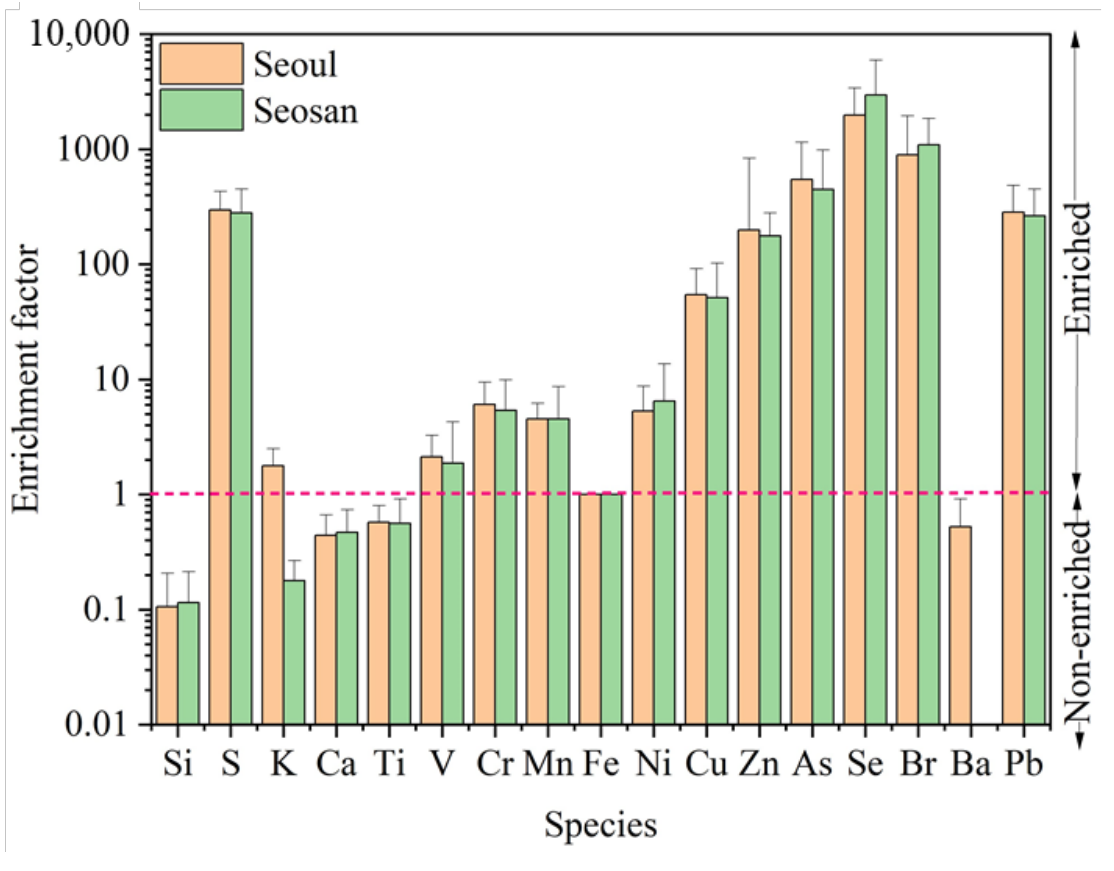
Figure 2. Enrichment factors of elements in PM 2.5 at the Seoul and Seosan sites (the variable of the Y -axis is in log 10 scale).